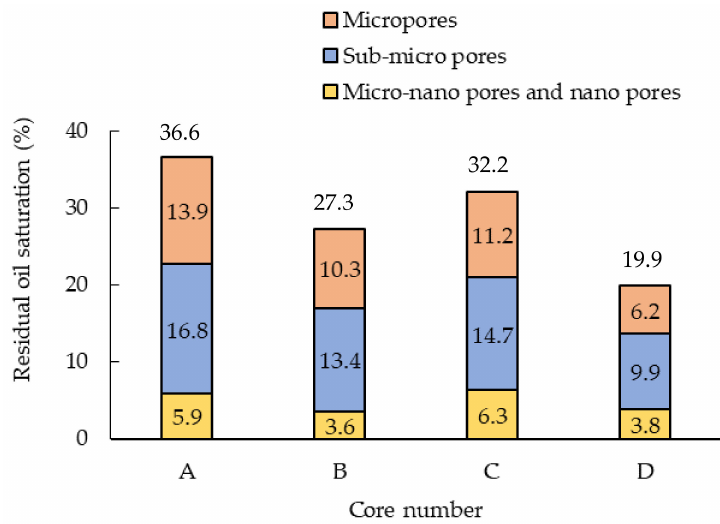
Figure 6. Residual oil saturations for the cores and their different